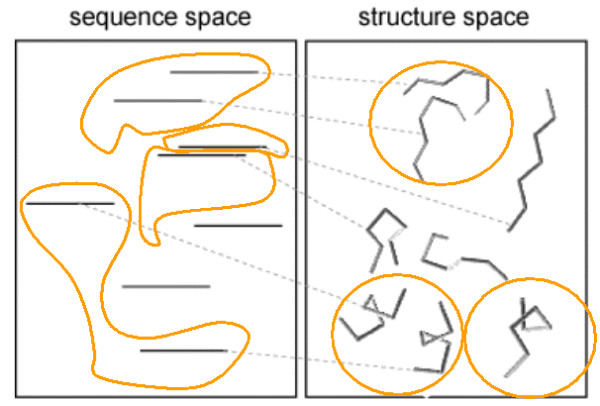
Clustering in structure space and using a nonlinear classifier for partitioning sequence space with respect to corresponding structure labels (Our Method).